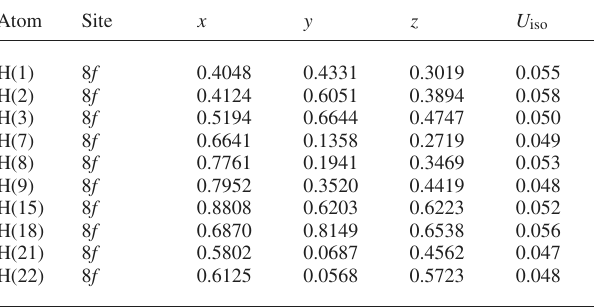
Table 2. Atomic coordinates and displacement parameters (in Å 2 )